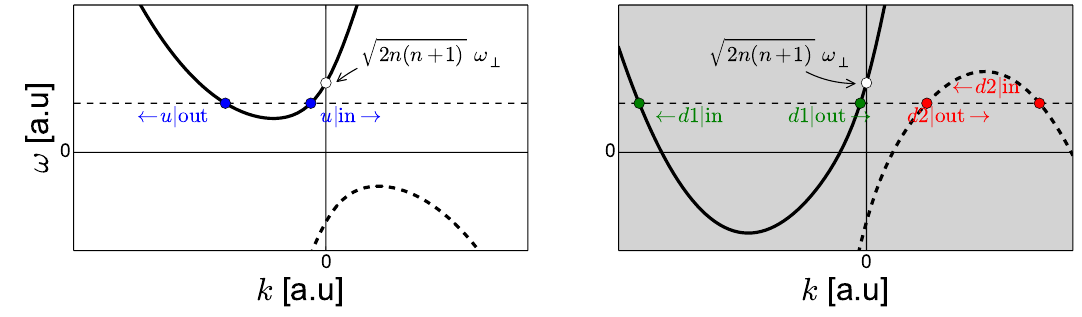
Figure 9: Sketch of the typical dispersion relations of a transverse mode in the subsonic (left plot) and supersonic (right plot) case. The horizontal dashed line is fixed by the chosen value of ω